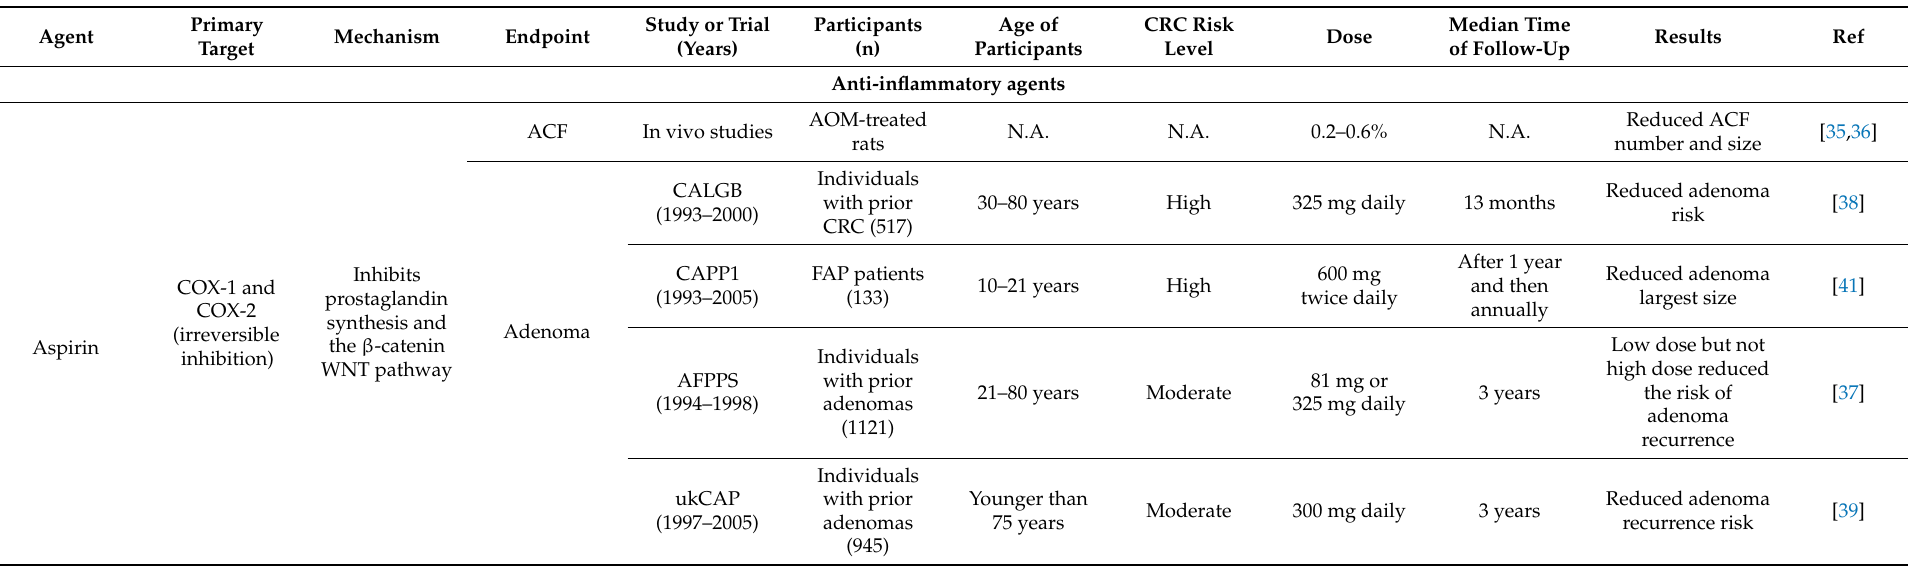
Table 1. Chemopreventive agents for CRC. Abbreviations: 5-ASAs, 5-aminosalicylates; ACF, aberrant crypt foci; AIM2, Absent In Melanoma 2; AMPK, 5-adenosine monophosphate-activated protein kinase; AOM, azoxymethane; APACC, Association pour la Pr é vention par l’Aspirine du Cancer Colorectal; APC, Adenoma Prevention with Celecoxib; APPROVe, Anomatous Polyp Prevention on Vioxx; ASCOLT, Aspirin for Dukes C and High-Risk Dukes B Colorectal Cancers; ASPIRED, Aspirin Intervention for the Reduction of CRC Risk; ATP, adenosine 5 (cid:48) -triphosphate; CALGB, Cancer and Leukemia Group B; CAPP, Colorectal Adenoma/Carcinoma Prevention Program; CCFR, Colon Cancer Family Registry; COX, cyclooxygenase; CPS II, Cancer Prevention Study II; CRC, colorectal cancer; DFMO, difluoromethylornithine; EB3IV, recombinant protein ERBB3 residues 269–396; EBX, extracellular amino acid residues 299–323 of ERBB3; EGFR, epidermal growth factor receptor; EPA, eicosapentanoic acid; ERBB3, Erb-B2 Receptor Tyrosine Kinase 3; FAP, familial adenomatous polyposis; FSP, frameshift peptides GAd, Great Ape Adenovirus; HMG-CoA, hydroxy- β -methylglutaryl-CoA; HPFS, Health Professionals Follow-up Study; KLH, keyhole limpet hemocyanin; IL-23, interleukin-23; HT001, protein asteroid homolog 1; MUC-1, mucin-1; MVA, Modified Vaccinia virus Ankara; N.A., not applicable; NA-NSAIDs, non-aspirin non-steroidal anti-inflammatory drugs; NHS, Nurses’ Health Study; PHS, Physicians’ Health Study; ppm, parts per million; Pre-Sap, Prevention of Colorectal Sporadic Adenomatous Polyps; PUFA, polyunsaturated fatty acid; RB, retinoblastoma; RCT, randomized controlled trial; seAFOod, Systematic Evaluation of Aspirin and Fish Oil; TAA, tumor-associated antigen; TF1B, TATA-Box Binding Protein Associated Factor, RNA Polymerase I Subunit B; UDCA, ursodeoxycholic acid; ukCAP, United Kingdom Colorectal Adenoma Prevention; USPSTF, US Preventive Services Task Force; WHS, Women’s Health